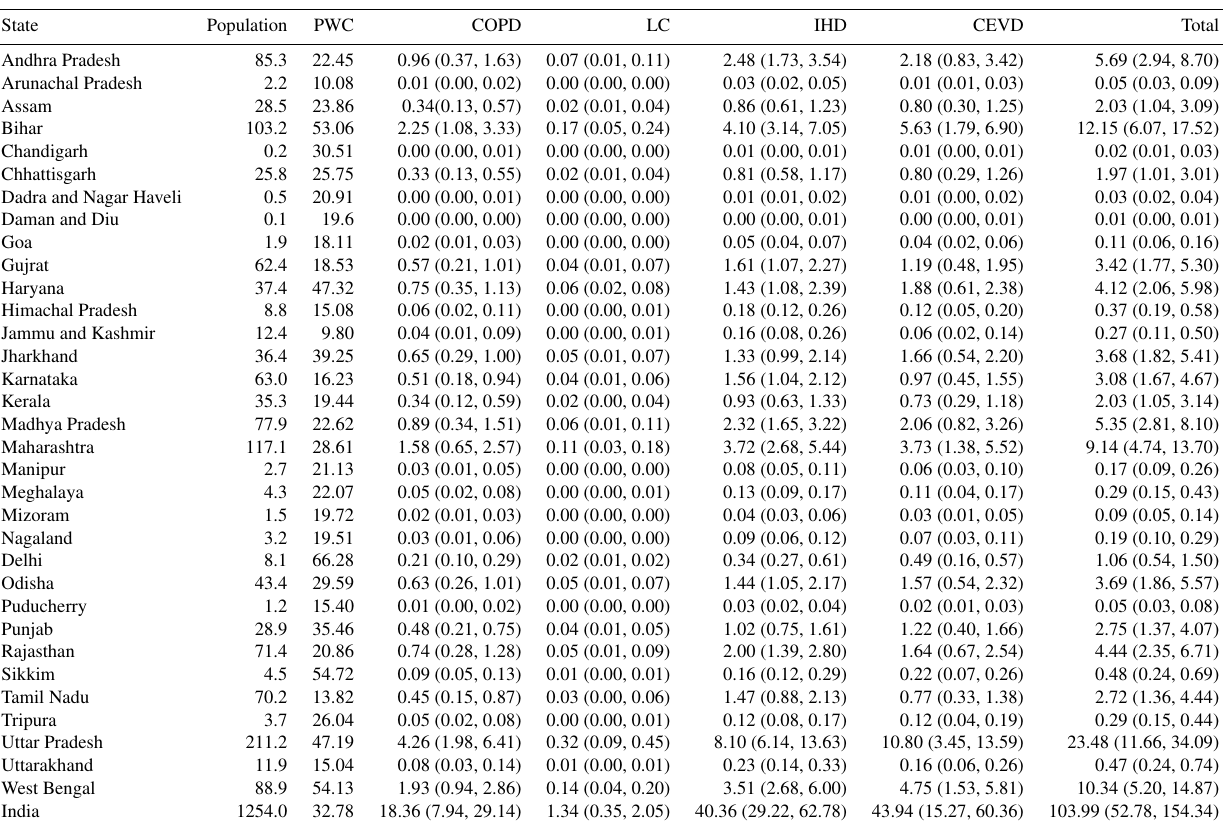
Table 1. Population ( × 10 6 ), population-weighted concentration (PWC, µgm − 3 ) and premature mortality ( × 10 4 deaths) due to COPD, LC, IHD, and CEVD in each state or union territory in